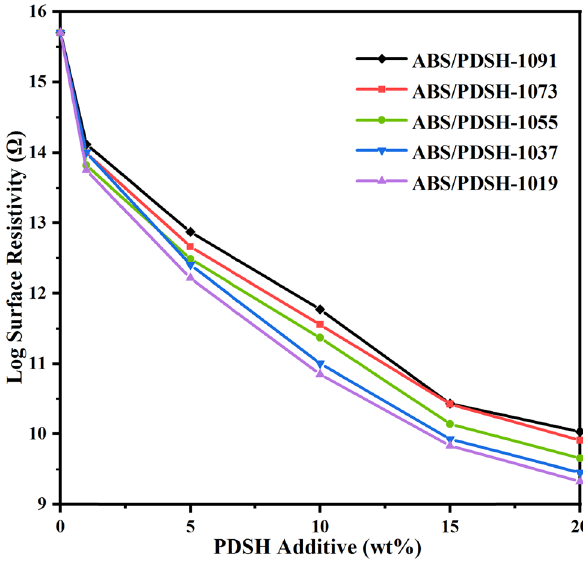
Figure 6: Surface resistivity changes of ABS/PDSH composites as a function of the antistatic agent content ( wt% )